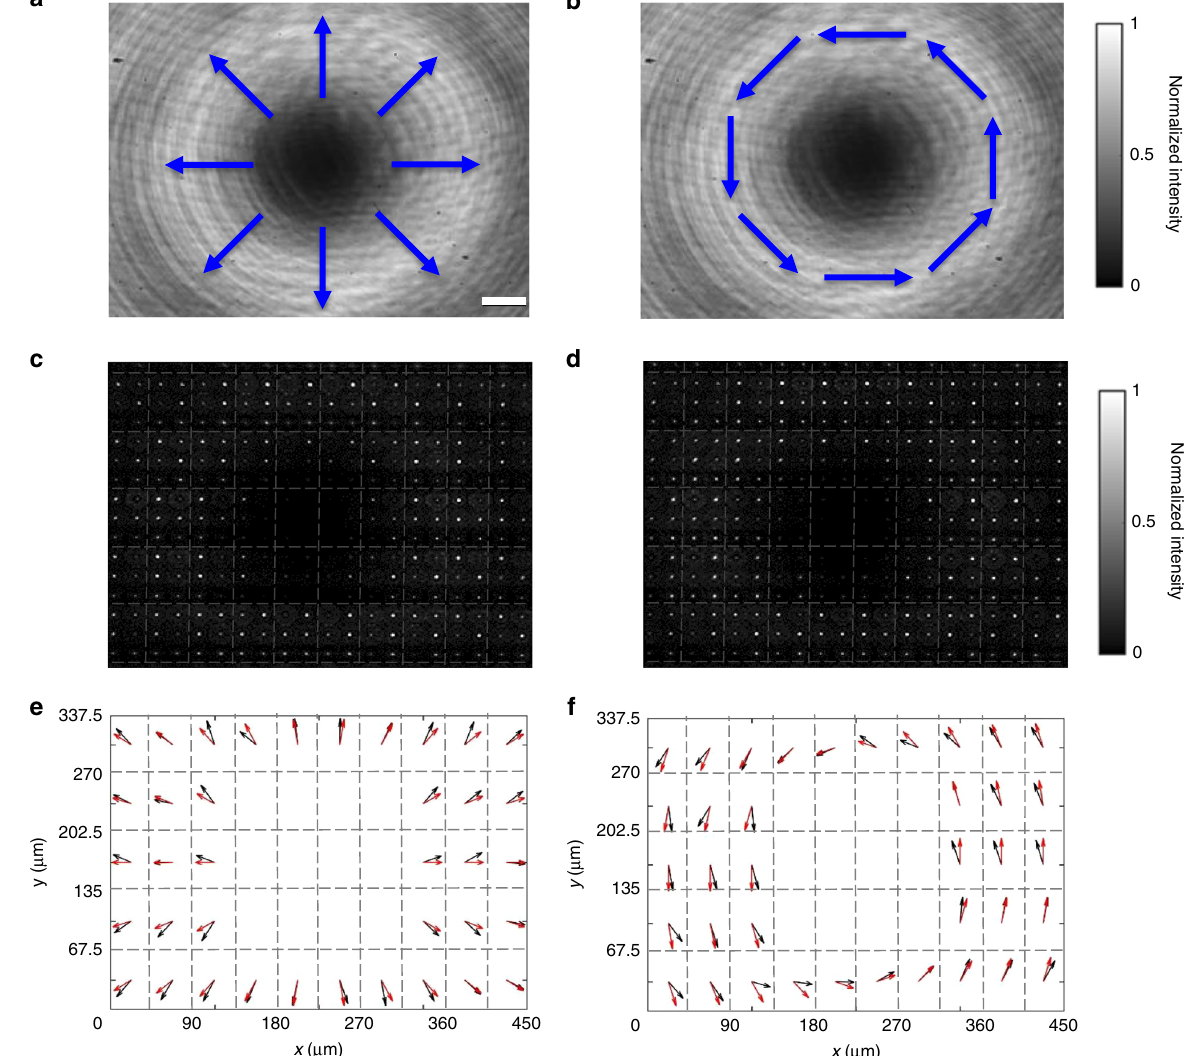
Fig. 4 Pro fi ling of vector beams by the metalens array. a , b Intensity distributions of focal spots for a radially polarized incident beam and an azimuthally polarized beam, respectively. The blue arrows qualitatively indicate the local polarization states. Scale bar: 50 μ m. c , d Images of focal spots from the metalens array for the radially polarized and the azimuthally polarized beam, respectively. e , f Polarization pro fi les. The black arrows correspond to the measured local polarization vectors, the red arrows to the calculated ones. The dashed gray lines highlight the individual pixels of the metalens array